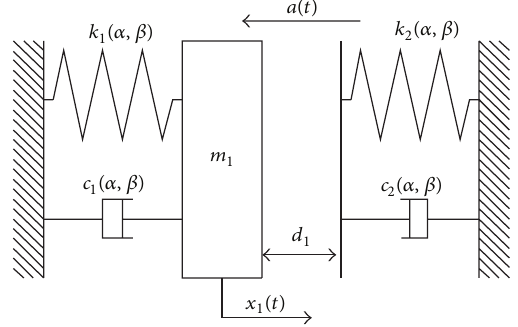
Figure 3: Physical model of the